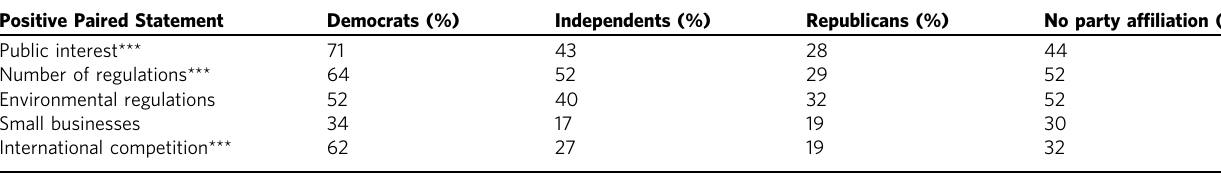
Table 3 Paired statements presenting regulations as more positive.